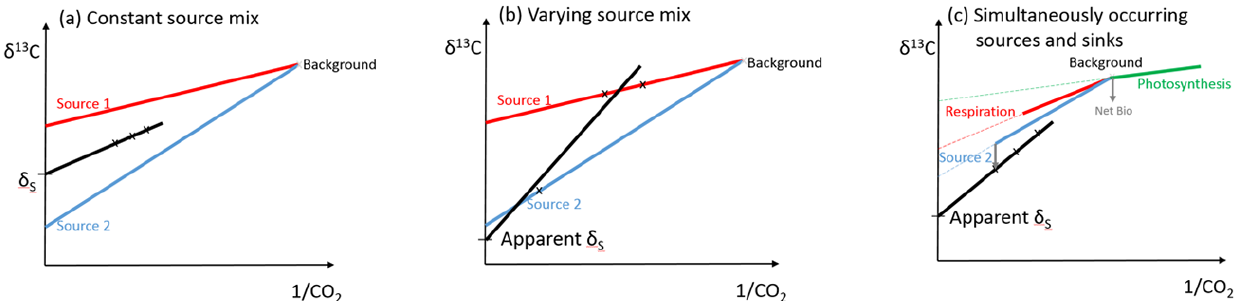
Figure 1. Regression-based determination of source signature using a Keeling plot. For clarity of illustration, we only draw three data points instead of five, which we use for our computation. (a) Constant source mix during the time of source signature determination leads to the correct flux-weighted mean isotopic signature (following Eq. A1), δ S . (b) Change of source mix during the period of determination of a Keeling plot due to either a temporal change of emission characteristics or a wind direction change (transportation) leads to a biased result. These situations can be usually identified by a large error of the intercept, δ S (we choose an error > 2‰ to reject these results). (c) Sources and sinks with different isotopic signatures or sink fractionation occur at the same time and lead to a wrong apparent source signature. Strong biases are prevented by choosing a minimum net CO 2 concentration range of 5ppm and demanding a monotonous increase of CO 2 during the 5h (see text for more details). Note that the background value is displayed for illustration, but it is not used in the moving Keeling plot